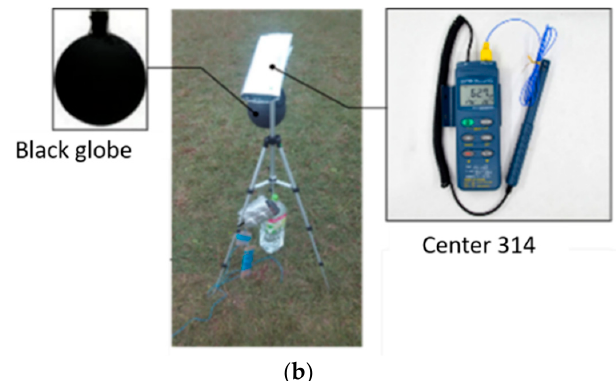
Figure 5. ( a ) Distribution of measurement points within the study area ( b ) The measurement instruments.